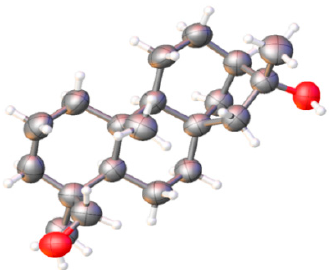
ff raction perspective of phyllocladan-16 α , 19-diol ( 1 Figure 2 . X-ray diffraction perspective of phyllocladan-16 α , 19-diol ( 1 ). Figure 2. X-ray di Figure 2 . X-ray diffraction perspective of phyllocladan-16 α , 19-diol ( 1 ).